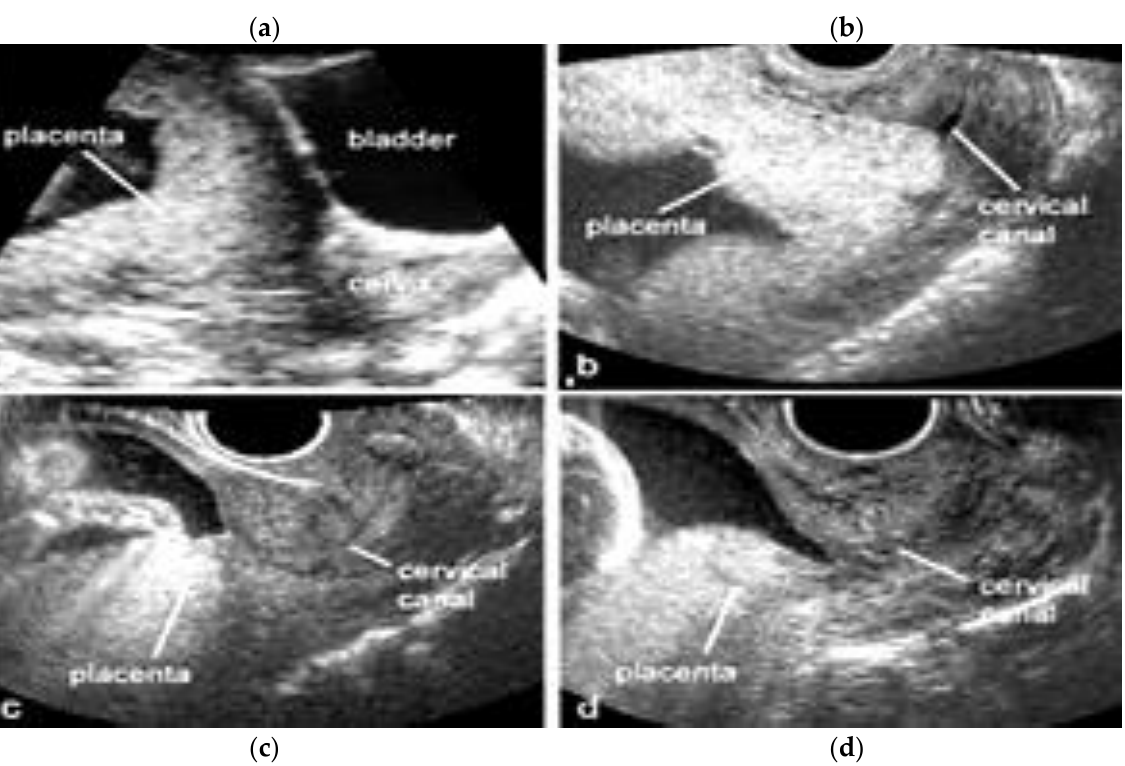
Figure 3. Transvaginal two-dimensional ultrasound showing placenta praevia major (upper panel, a , b ) and a placenta praevia minor (lower panel, c , d ).